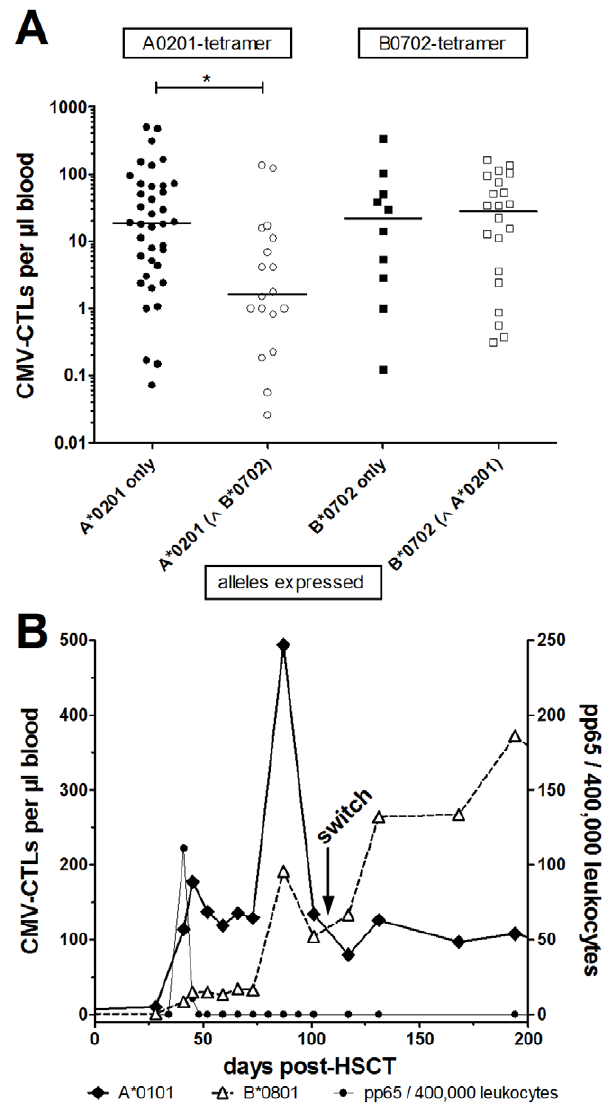
Figure 3. Specific HLA combinations influence the CMV-CTL levels. ( A ) Median CMV-CTL levels in patients expressing only and monitored with HLA-A*0201 (filled circles) or HLA-B*0702 (filled squares) tetramers, respectively, were calculated and compared to the levels in patients expressing both alleles. The level of HLA-A0201 CMV- CTL (white circle) was significantly lower in patients expressing HLA- A0201 and –B0702 compared to those only expressing the A0201 allele (filled circles). No such difference was found for HLA-B0702-binding CTL levels between patients who only express the B0702 allele (filled square) or both A0201 and B0702 alleles (white squares). ( B ) The median numbers of CMV-CTLs detected by each tetramer were compared in all patients monitored with at least 2 different tetramers (n=176/278). The analysis for one patient is shown as an example. The number of CMV-CTLs detected by each tetramer are plotted over time. CMV reactivation occurred on day + 41 (spike in the pp65 line), triggering CMV-CTL expansion. HLA-B*0801 detected the highest numbers of CMV-CTLs until day + 100 when a switch occurred. * p # 0.05. immune reconstitution with 1 CMV-CTL per m l blood with (n =30) or without (n =21) CMV reactivation. CMV reactivation was recurrent in all 30 of the 51 patients who did experience